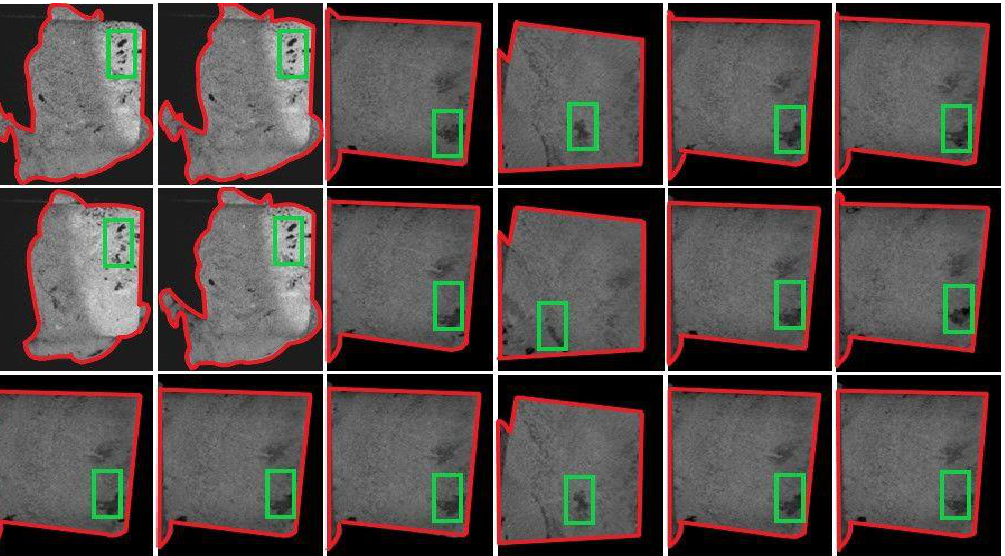
Figure 7. Regions enclosed by green boxes show the deep CNN model output. This figure clearly shows the lesser identification accuracy of deep CNN compared with the proposed pixel-wise k -IN approach.